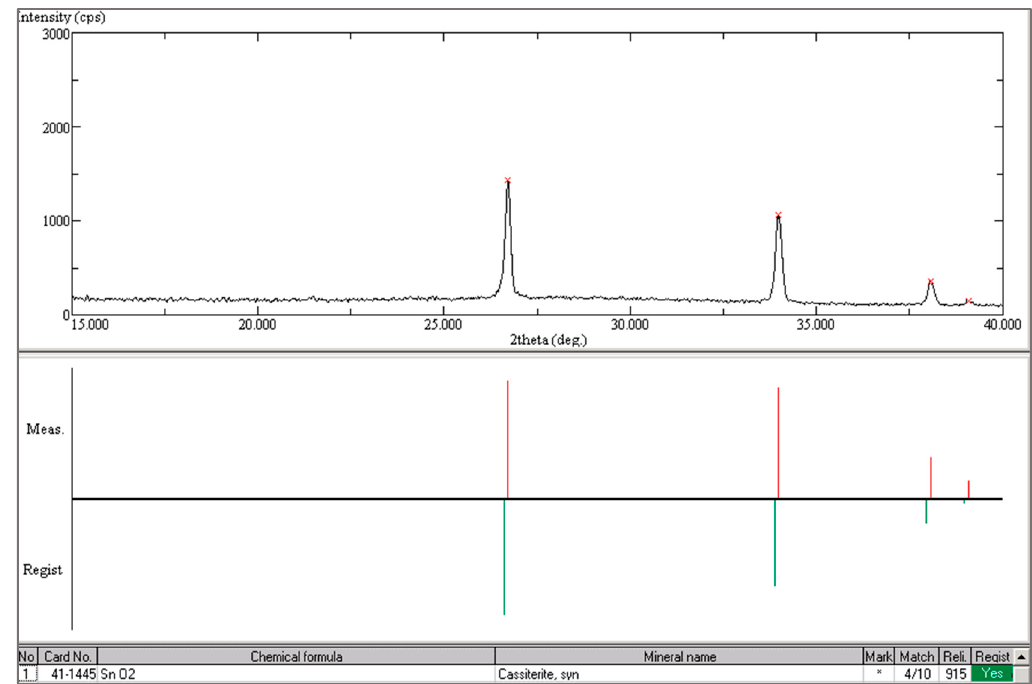
Severo in Classe, Ravenna—unpublished data ).